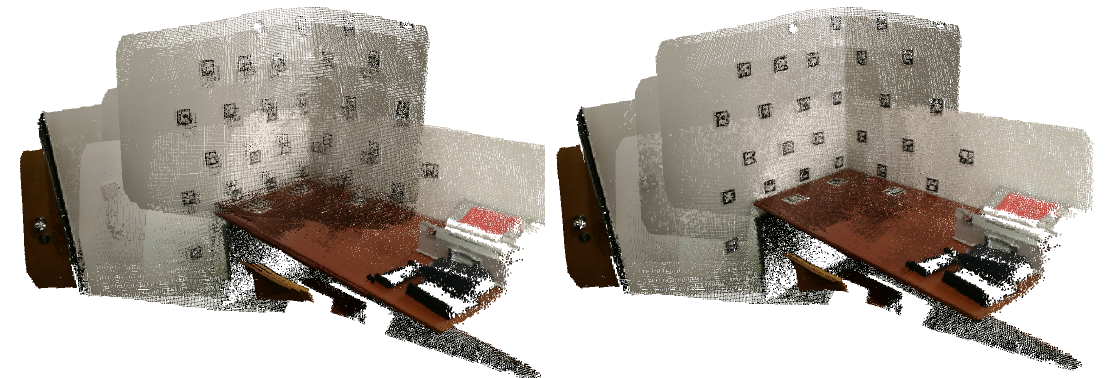
Figure 4. Merged point cloud coloured with texture obtained from images: ( left ) before optimization; ( right ) after